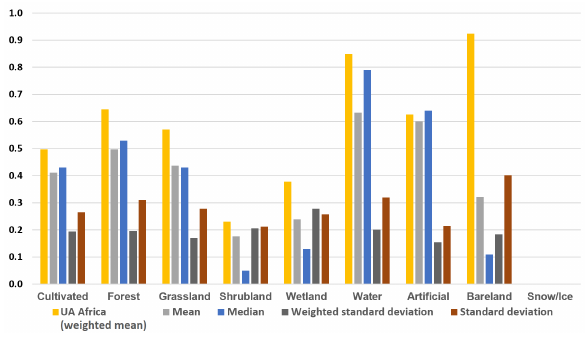
Figure 3. Summary statistics of UA